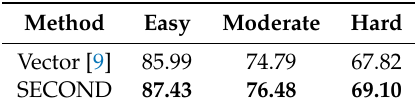
Table 6. A comparison of the performances of different angle encoding methods on the KITTI validation set for the Car class.